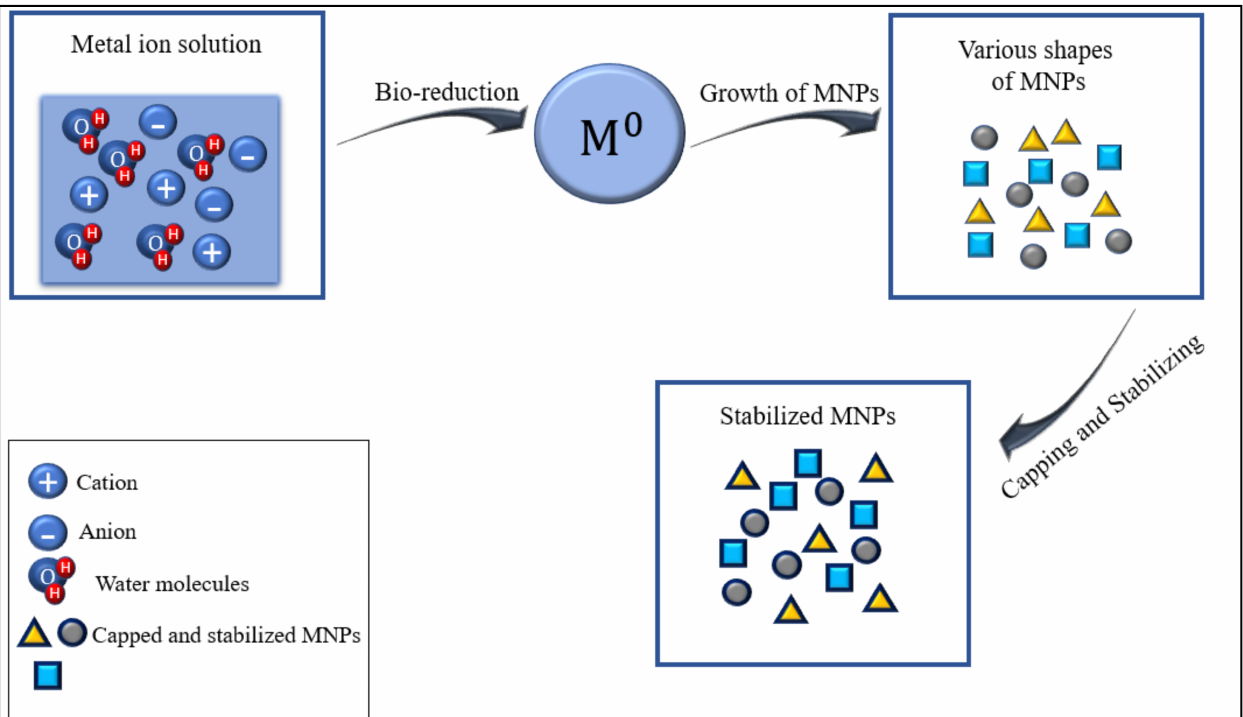
Figure 3. Chemical reduction and stabilization of MNPs. Reduction of the metal salt solution is done by the presence of secondary metabolites in plant extracts such as (phenols, polyphenols, and flavonoids) to maintain zero-valent metals. Then, MNPs with various shapes and sizes are yielded, followed by coating and stabilizing with capping agents (secondary